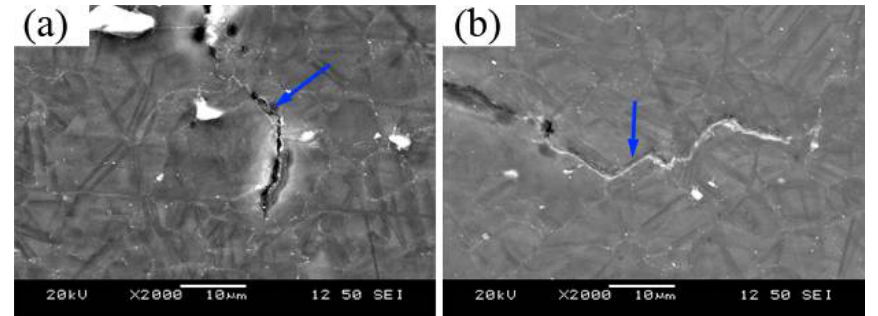
Figure 8. Crack propagation paths of M-FSP AZ61 plates during Erichsen cupping test at a punching speed of 0.1 mm/min: ( a ) along grain boundaries and ( b ) along twin boundaries.